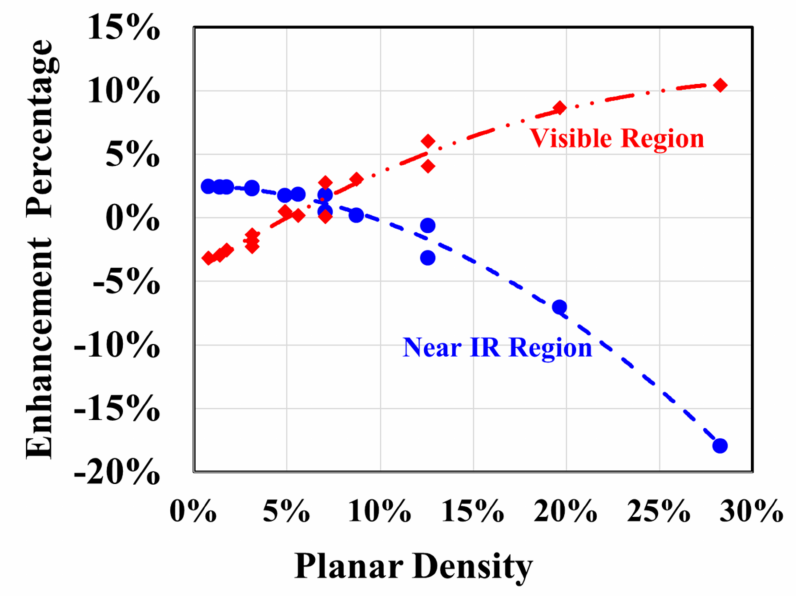
Figure 6. Enhancement percentage in the absorption of the proposed different solar cell structures as a function of the planar density of plasmonic Al nanoparticles layer.